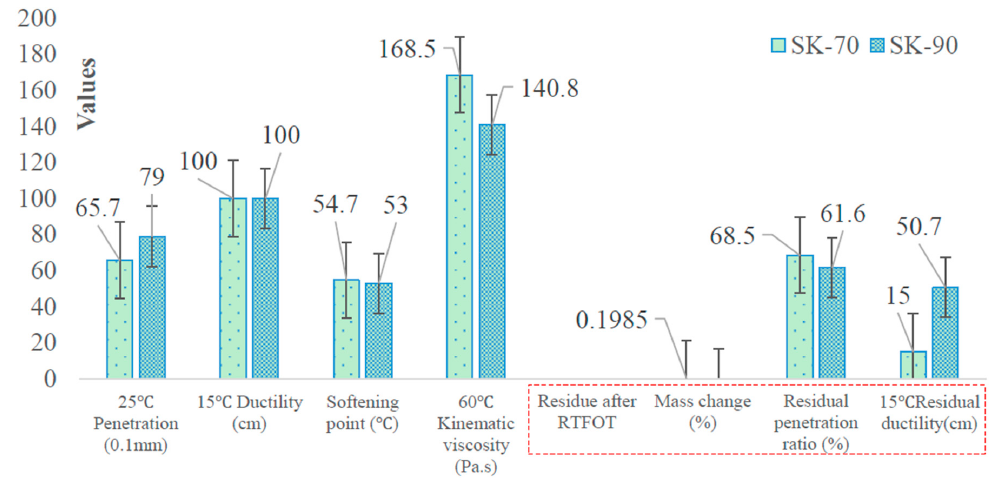
Figure 1. Properties of SK-70 and SK-90 asphalt (RTFOT: Rolling Thin Film Oven Test).